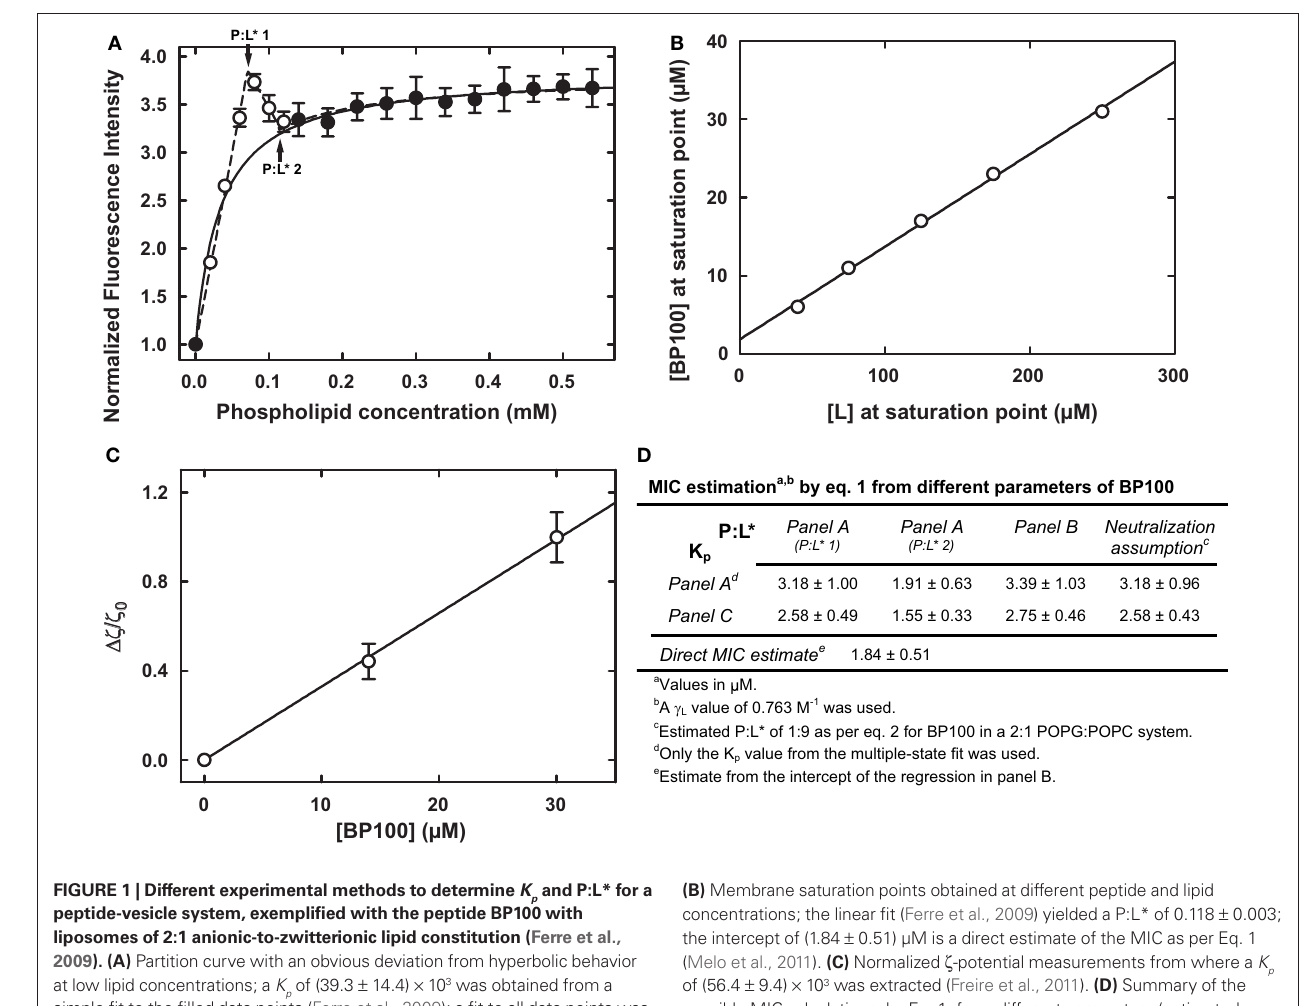
Figure 1 | Different experimental methods to determine K and P:L* for a (B) Membrane saturation points obtained at different peptide and lipid p peptide-vesicle system, exemplified with the peptide BP100 with concentrations; the linear fit (Ferre et al., 2009) yielded a P:L* of 0.118 ± 0.003; liposomes of 2:1 anionic-to-zwitterionic lipid constitution (Ferre et al., the intercept of (1.84 ± 0.51) μM is a direct estimate of the MIC as per Eq. 1 2009). (A) Partition curve with an obvious deviation from hyperbolic behavior (Melo et al., 2011). (C) Normalized ζ -potential measurements from where a K at low lipid concentrations; a K of (39.3 ± 14.4) × 10 3 was obtained from a of (56.4 ± 9.4) × 10 3 was extracted (Freire et al., 2011). (D) Summary of the p simple fit to the filled data points (Ferre et al., 2009); a fit to all data points was possible MIC calculations, by Eq. 1, from different parameters (estimated – possible by assuming the coexistence of different bound states (Melo and see Eq. 2 – or from panels A–C ); these overlap nicely with the 2.5–7.5 μM Castanho, 2007), yielding a K of (45.8 ± 13.8) × 10 3 and two P:L* values, of range where BP100 is active against different Gram-negatives (Ferre et al., p 0.111 ± 0.01 and 0.067 ± 0.008, respectively (indicated by arrows). 2009; Alves et al.,